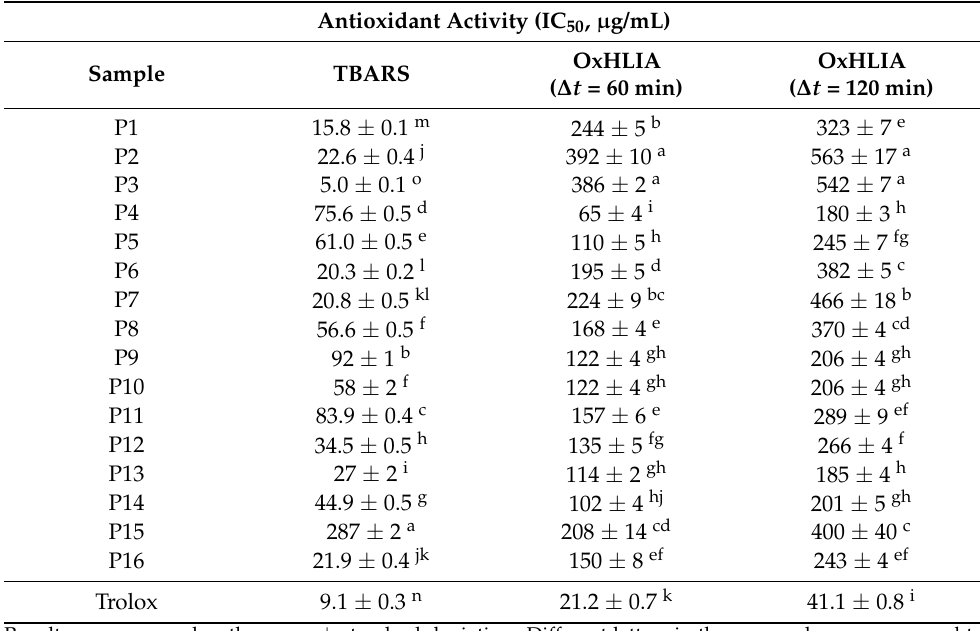
Table 3. Antioxidant activity of the hydroethanolic extracts of cardoon